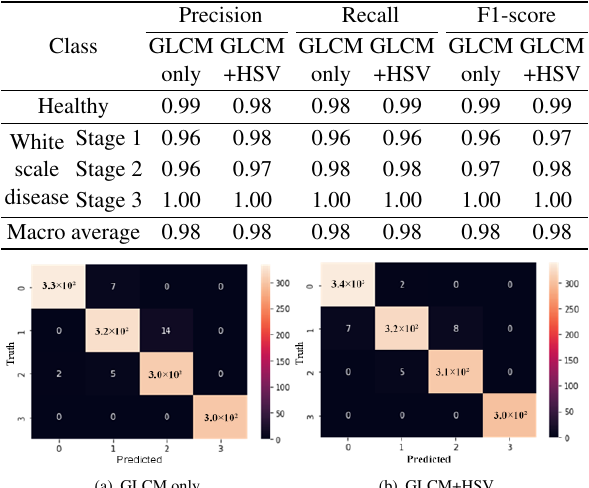
Table 2 Performance comparison of SVM classification on GLCM only and GLCM+HSV features.